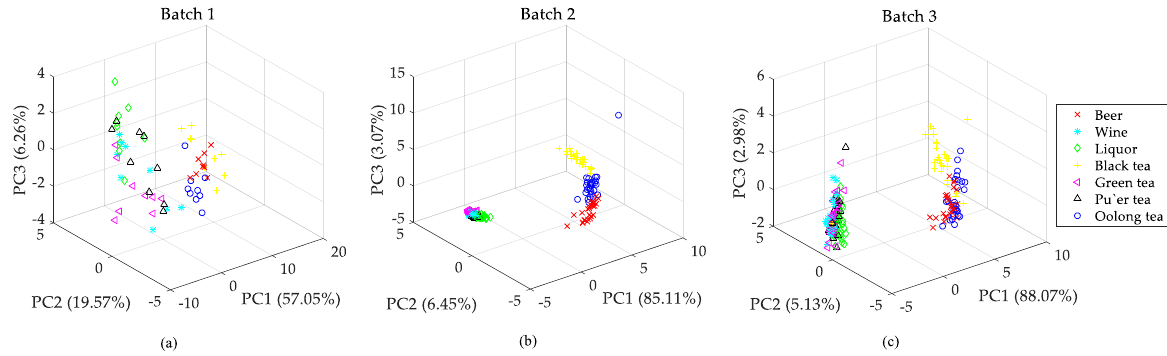
Figure 5. Data distribution of dataset B. ( a ) Distribution of batch 1, ( b ) distribution of batch 2, ( c ) distribution of batch 3. Table 3. Parameter values of the